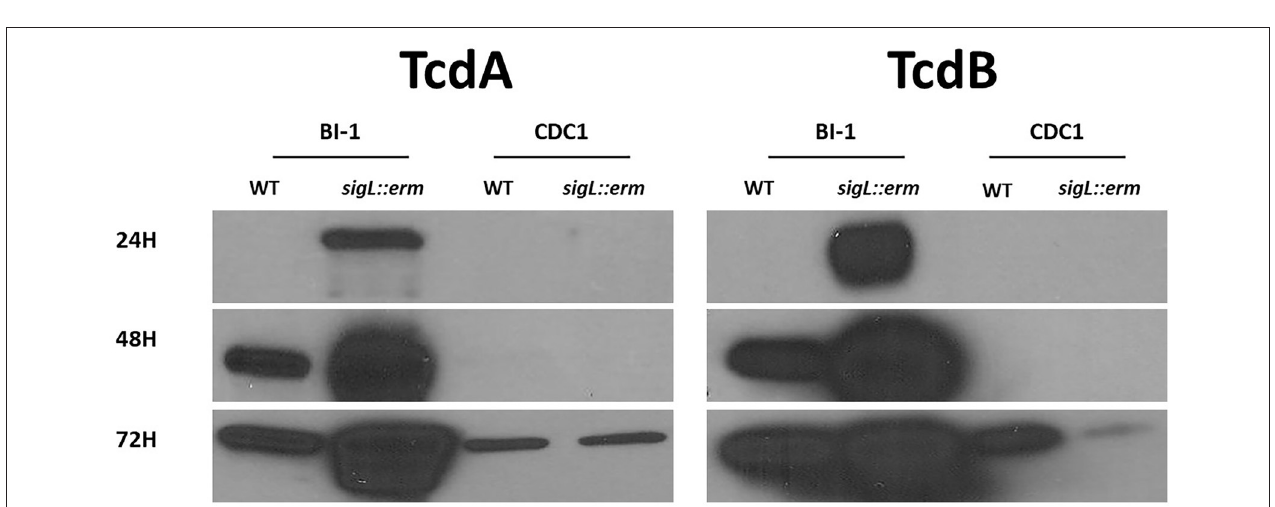
FIGURE 9 | Supernatant toxin level is differentially altered in sigL::erm in BI-1 and CDC1 backgrounds. BI-1 and CDC1 C. difficile strains and respective sigL::erm mutants were grown for 24, 48, and 72h. Vegetative cells were removed by centrifugation and the supernatant was assayed for toxins by immunoblotting using monoclonal antibodies against TcdA and TcdB. Blots are representative of three